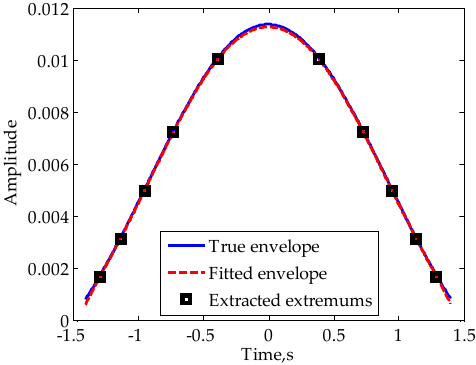
Figure 8. Fitting of the envelope in mainlobe.